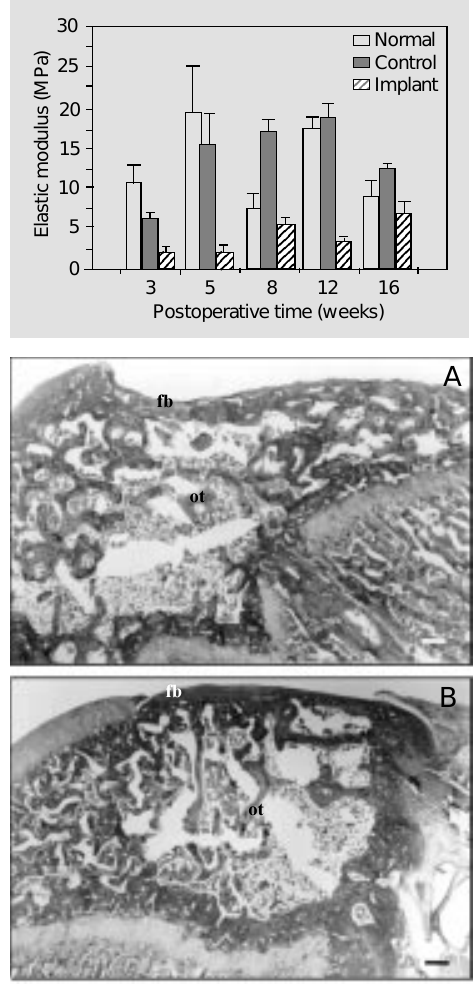
(weeks)Figure 2 - Average values of the elastic modulus obtained from experimental measurements of load needed to make a 0.16-mm indentation depth. Data are shown for normal articular carti- lage surfaces, control repaired surfaces and surfaces repaired with the hydrogel implant for dif- ferent postoperative periods.